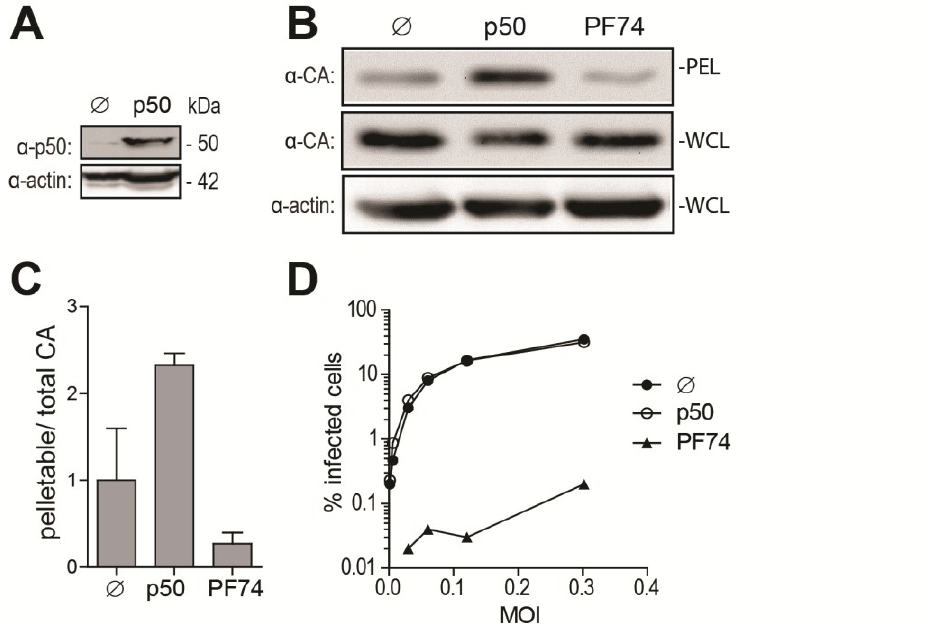
Figure 3. Over-expression of p50/dynamitin affects HIV-1 uncoating. ( A ) Western blot analysis of p50 and actin expression in HeLa cells 2 days after transfection with a plasmid encoding p50 or an irrelevant plasmid (pMIP; ø); ( B , C ) Fate-of-capsid analysis; ( B )